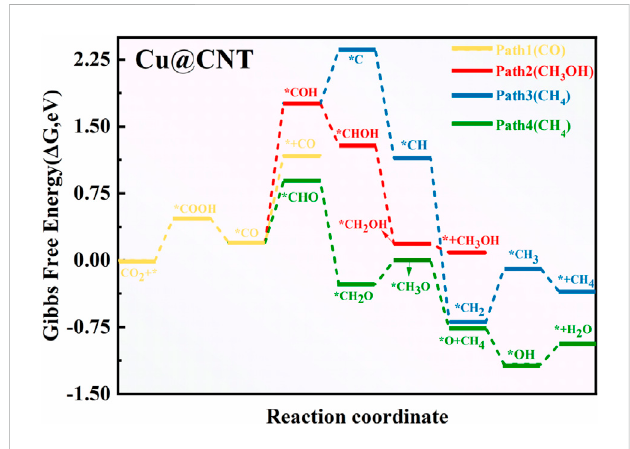
Free energy diagram of CO 2 RR on